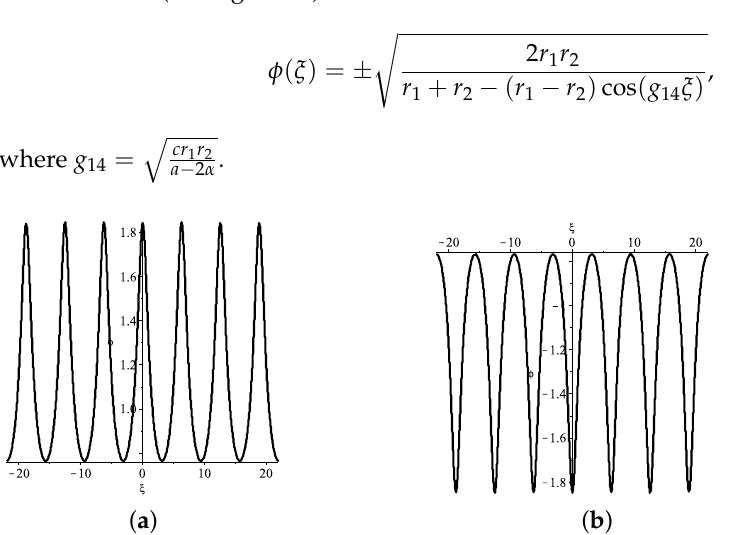
Figure 24. Periodic wave forms of system (5). ( a ) Defined by (62) + . ( b ) Defined by (62) −